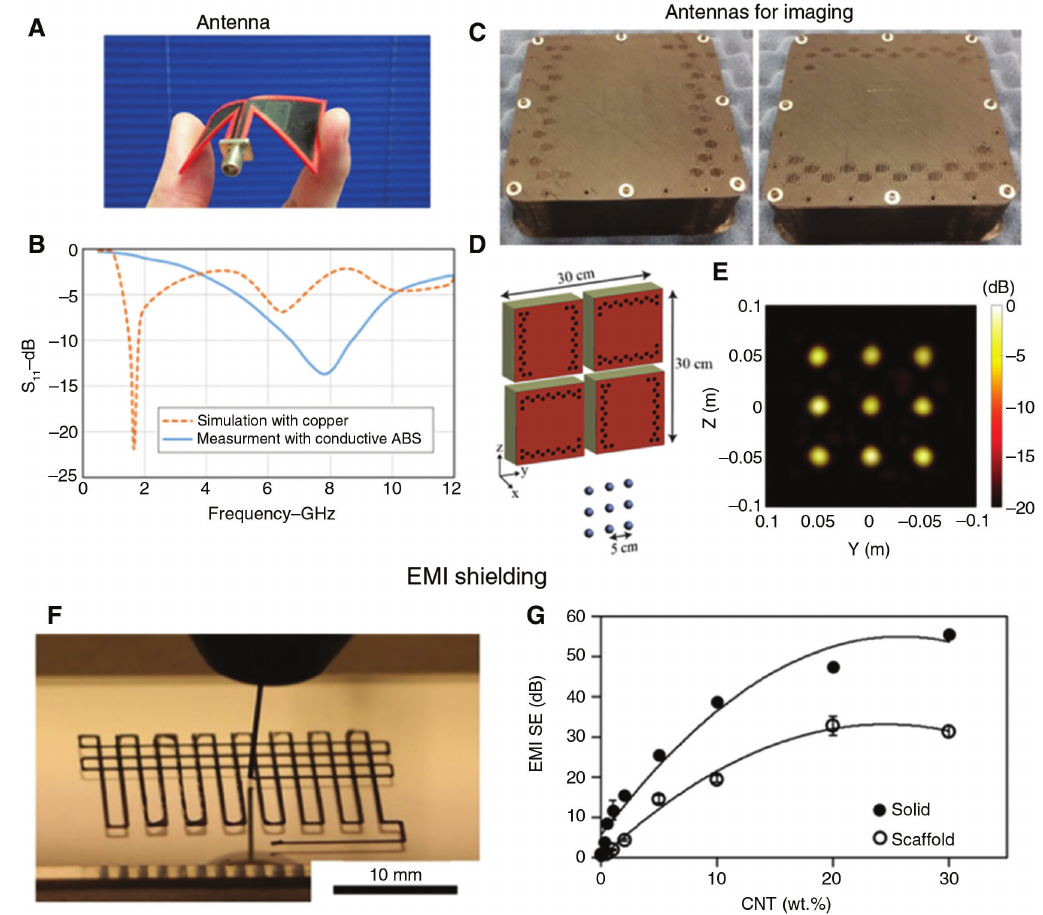
Figure 3: Conductive materials for microwave